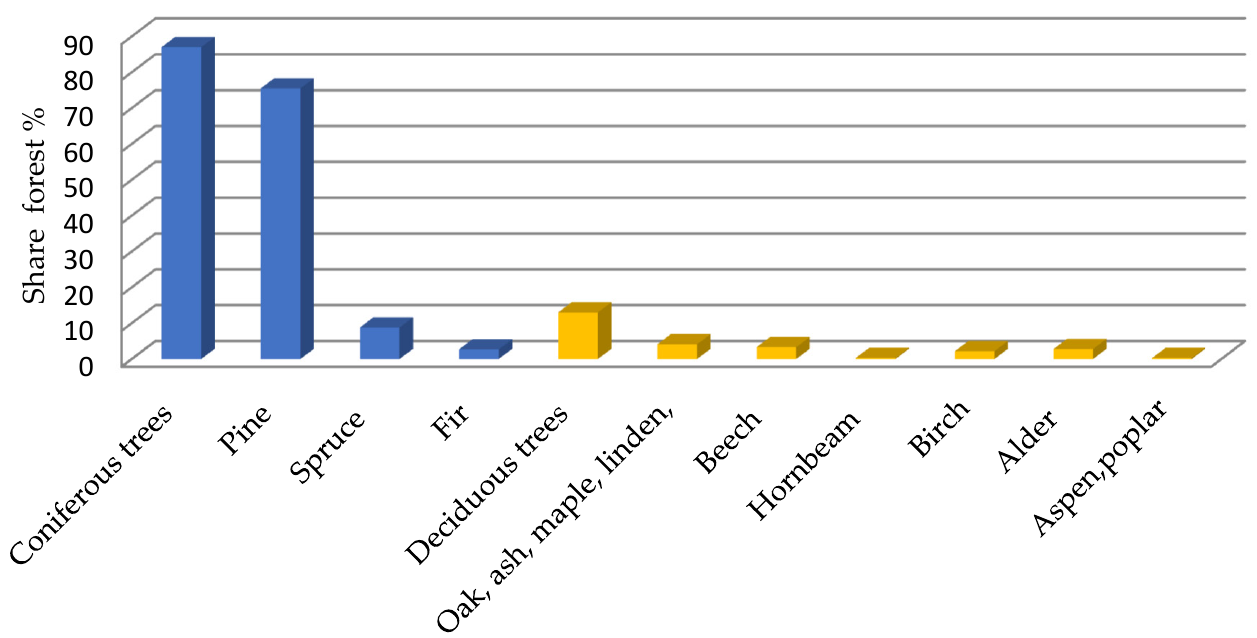
Figure 2. Structure of the basic share of the occurrence of species of forest resources in Poland [88–90].